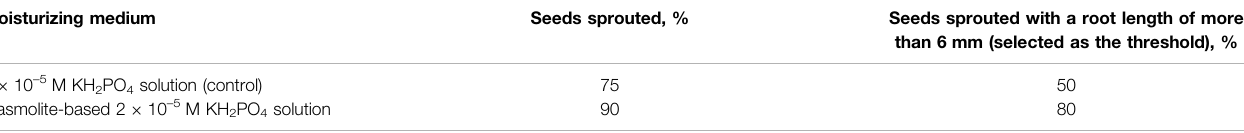
TABLE 2 | Percents of spring rye seeds, grade “ Onokhoyskaya ” , that developed root systems three days after the beginning of the seed germination on a soaked paper towel in a Petri dish at a temperature of +20 ° C for the two moisturizing mediums tested. Moisturizing medium Seeds sprouted, %